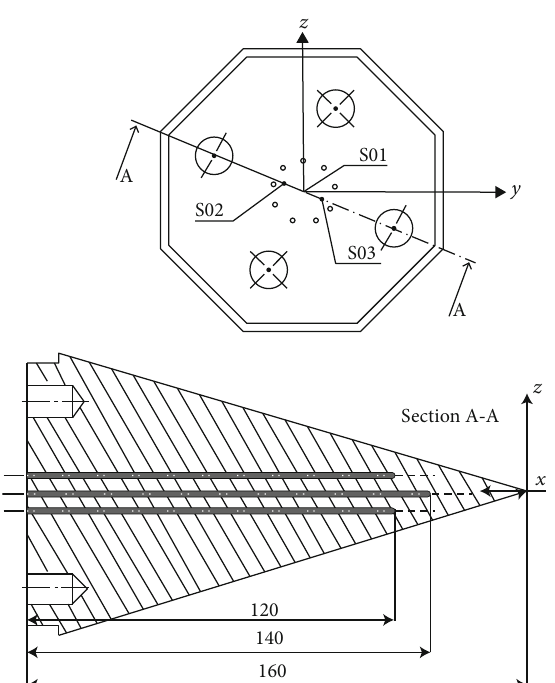
Figure 9: Leading-edge instrumentation.